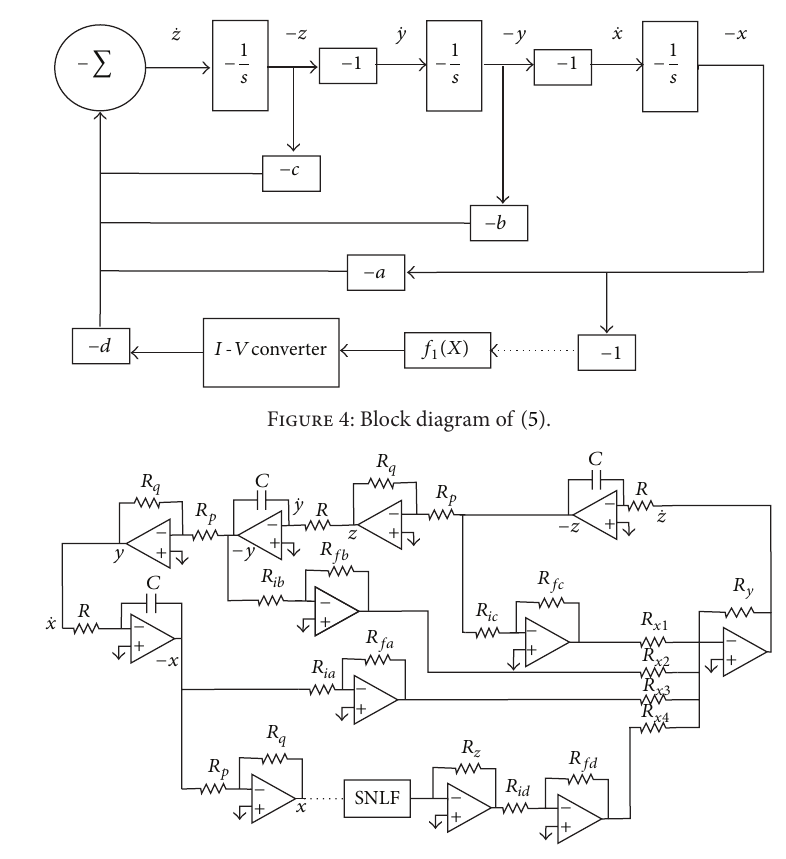
Figure 5: Realization of Figure 4 using